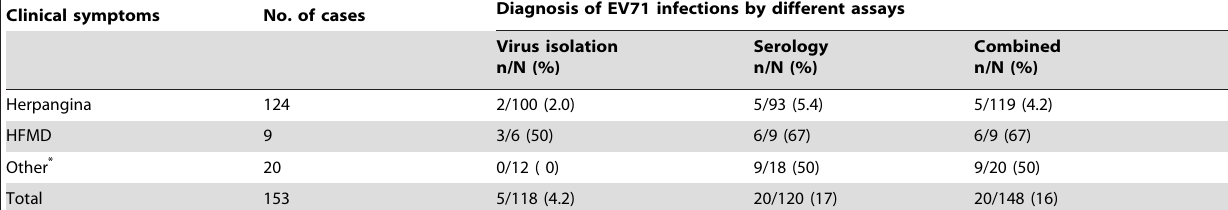
Clinical symptoms